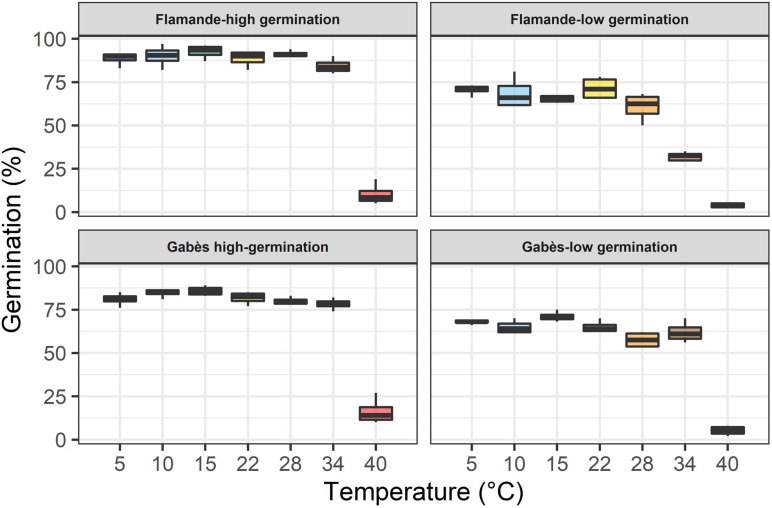
Boxplot showing average germinability (ymax parameter of the model) of two seed lots for two accessions (Flamande and Gabès) in response to temperature.